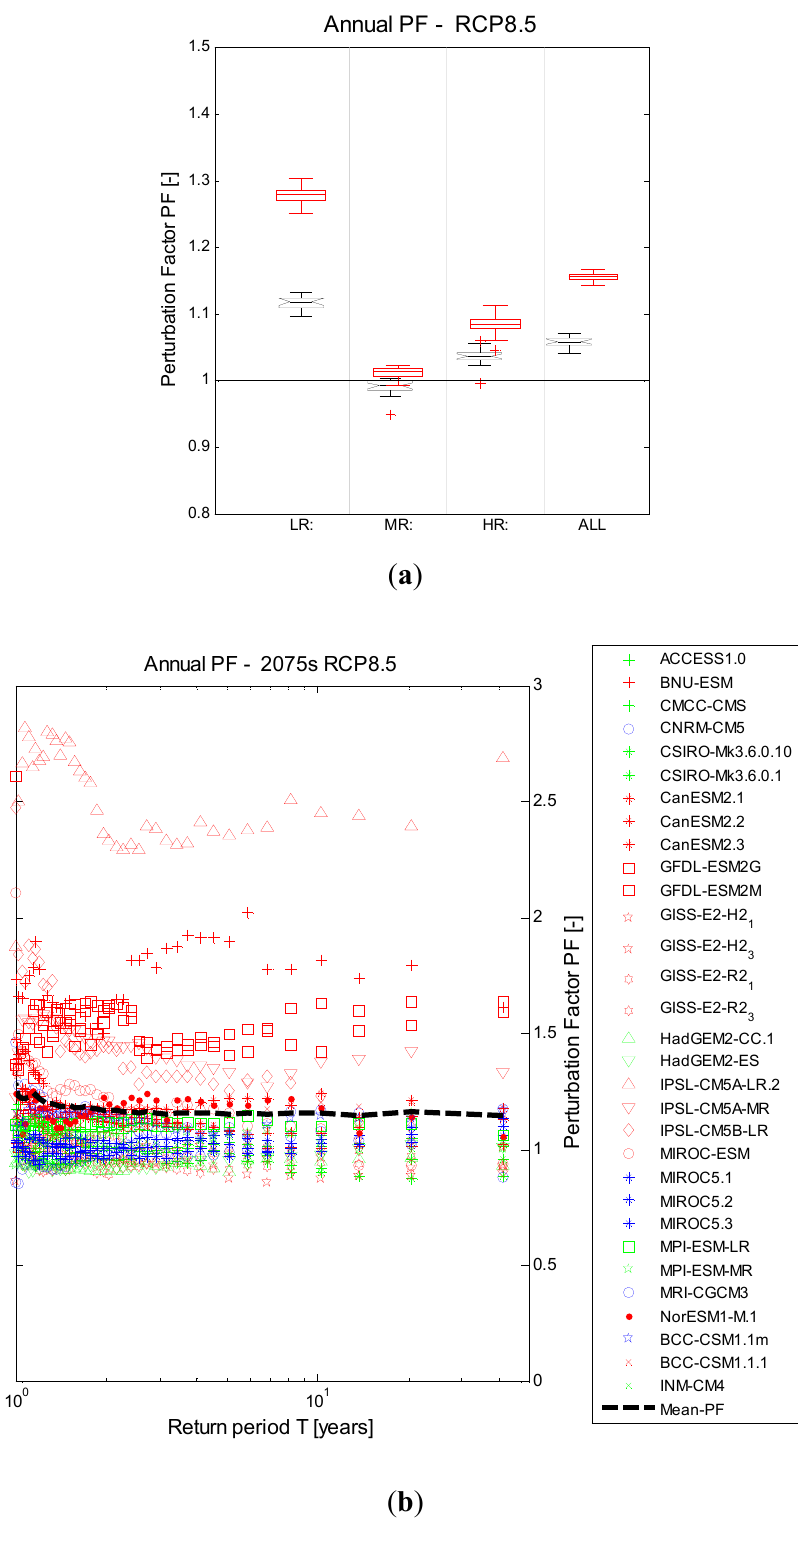
Figure 11. ( a ) Perturbation factors for annual precipitation using events with return periods greater than two years for the different GCMs, for the 2040s (notched) and 2075s for RCP8.5; ( b ) Perturbation factors vs. return period for annual precipitation for the different GCM simulations for the 2075s under RCP8.5 scenario: Red = LR GCMs, Blue = HR GCMs and Green = MR